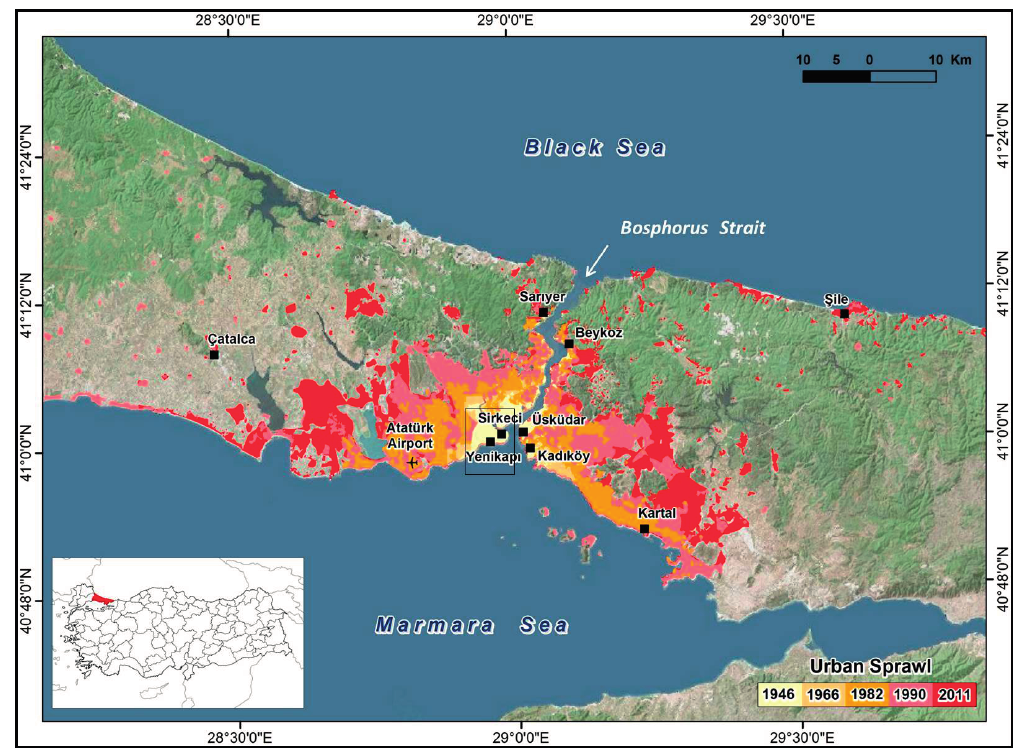
Figure 1. Map showing the temporal and spatial pattern of urbanization for Istanbul megacity, from 1946 to 2011 (adapted from [55]). Black polygon shows location of the Golden Horn peninsula study area.